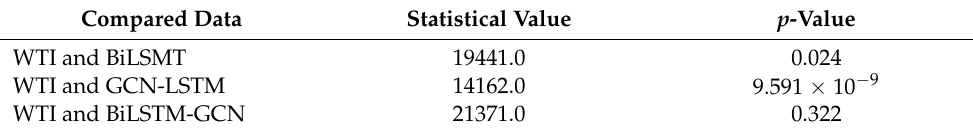
Table 6. Wilcoxon test results.